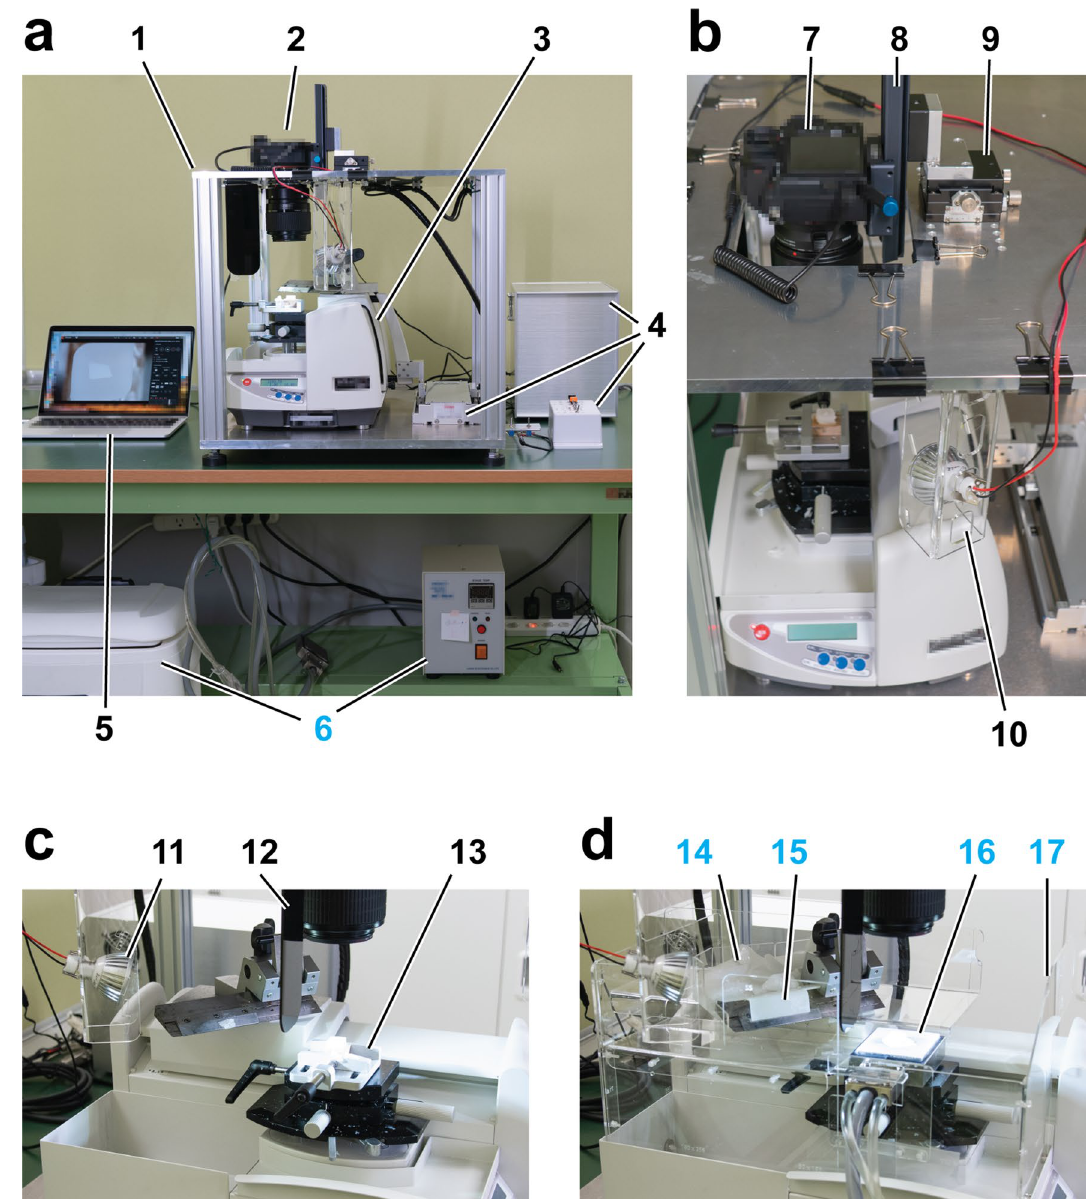
Figure 1. CoMBI system using a sliding microtome. CoMBI-S. ( a ) The front view of the whole system. The aluminum frame (1) consists of top and bottom plates and four pillars. Camera (2) is attached to the top plate. The sliding type microtome (3) is placed on the bottom plate and its handle is attached to a linear motor (4, left). A microcontroller in the box and switches regulate the linear motor and camera shutter release (4). A laptop computer is used for monitoring the block face and storing images (5). In case of frozen specimen, thermoelectric controller and ice water container are used for cooling a specimen holder (6). ( b ) The top view of the system. Camera (7) is attached to the top plate via focusing rail for Z positioning (8) and XY positioning stage (9). Two LED lamps at the front and back of specimen illuminate the block face diagonally (10, 11 in c ). ( c ) The side view of the setup for paraffin-embedded specimens. The shading plate (12) and specimen holder (13) are shown. ( d ) The side view of the setup for frozen specimens. Dry ice for cooling knife (14), frost distributor (15), specimen holder cooling by Peltier element (16), and plastic walls for keeping the cutting environment cool (17) are